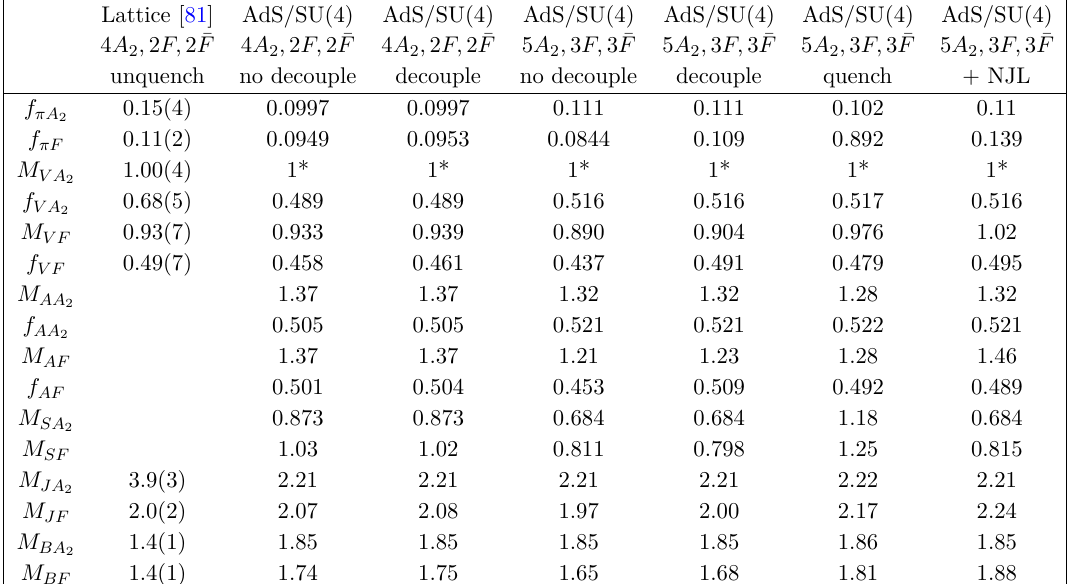
Table 5. SU(4) theories — the spectrum in a variety of scenarios and lattice data for comparison. the running of α at any scale — the gold line corresponds to the A representation and 2 the green the fundamental. There is a small gap with the fundamentals a little lighter. If we decouple the A fields at scales below their IR mass L then the fundamental L ( ρ ) 2 IR becomes the red embedding. Plot 17b is a zoom in showing the difference between the non-decoupled and the decoupling cases — in this model the separation barely changes when the decoupling is